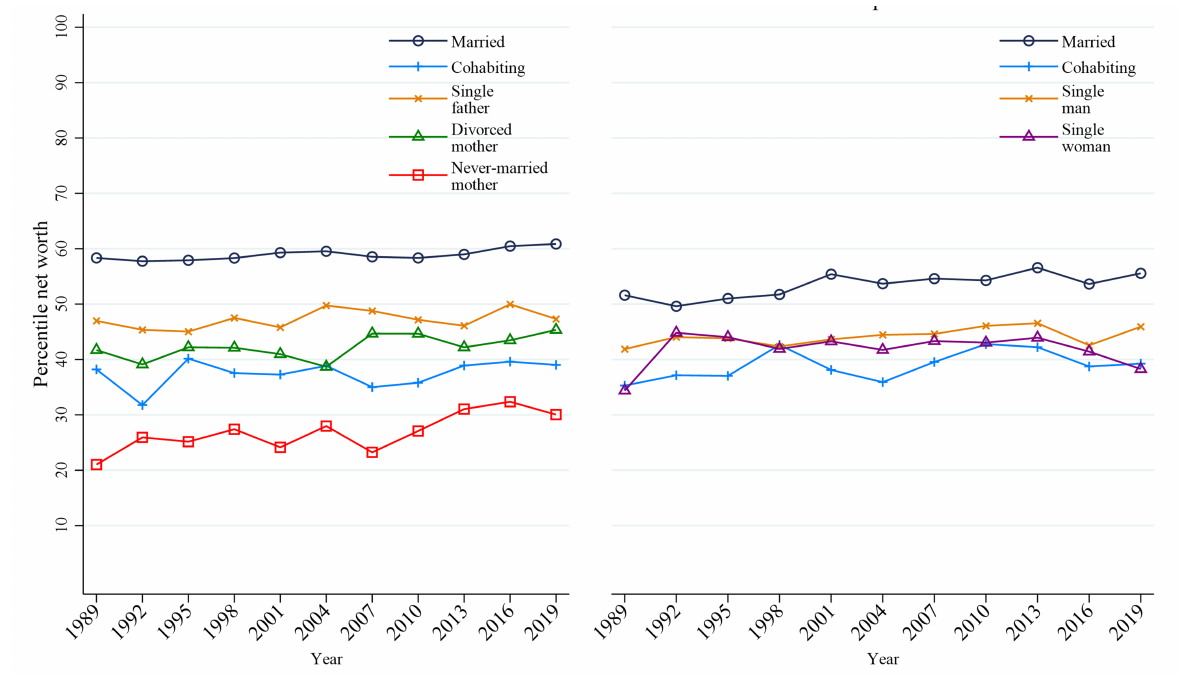
Figure 2: Mean percentile net worth by household type and year.